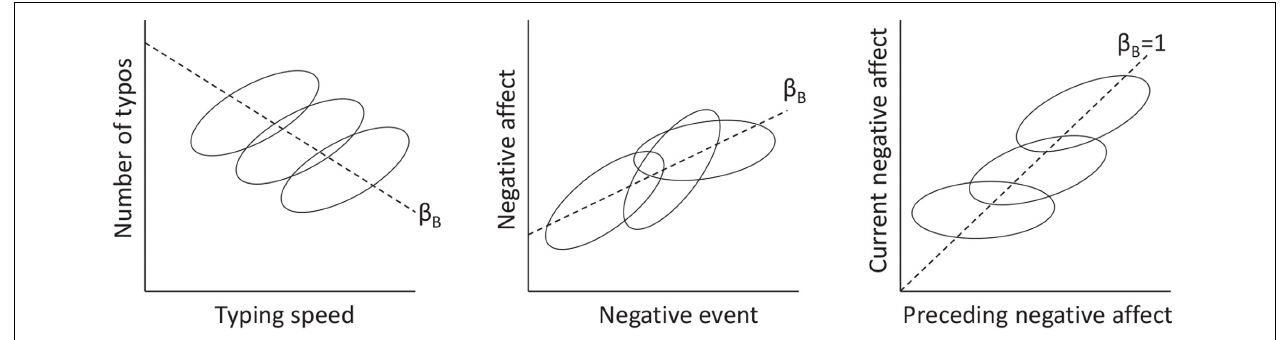
which may have a different sign as the within-person slope ( Left panel ), may be similar to the (average or fixed) within-person slope ( Middle panel ), or may be larger than the (average or fixed) within-person slope ( Right panel